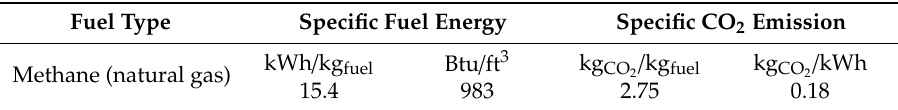
Table 6. Natural gas properties.